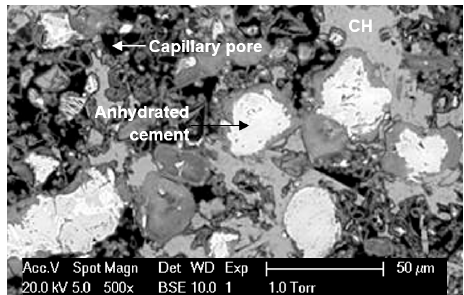
Figure 11. BSE image of the microstructure of OPC paste (w/b = 0.4, 28 days) [21].